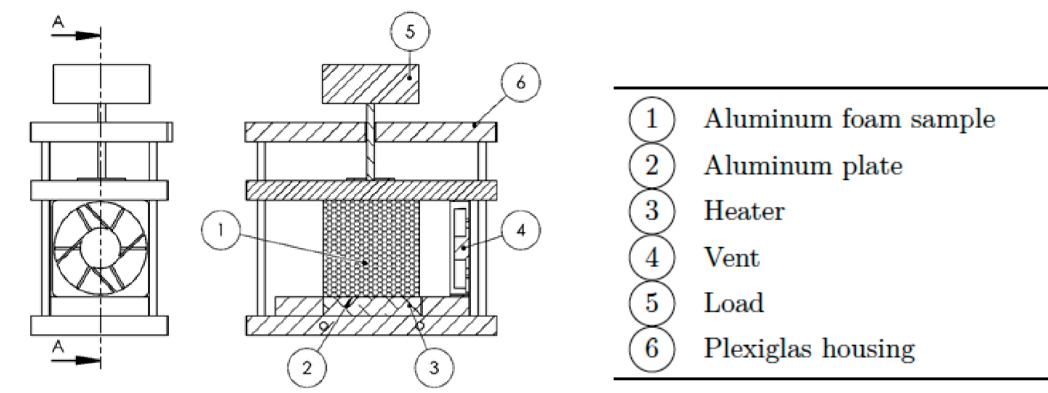
Figure 5. Schematic representation of the experimental set-up.